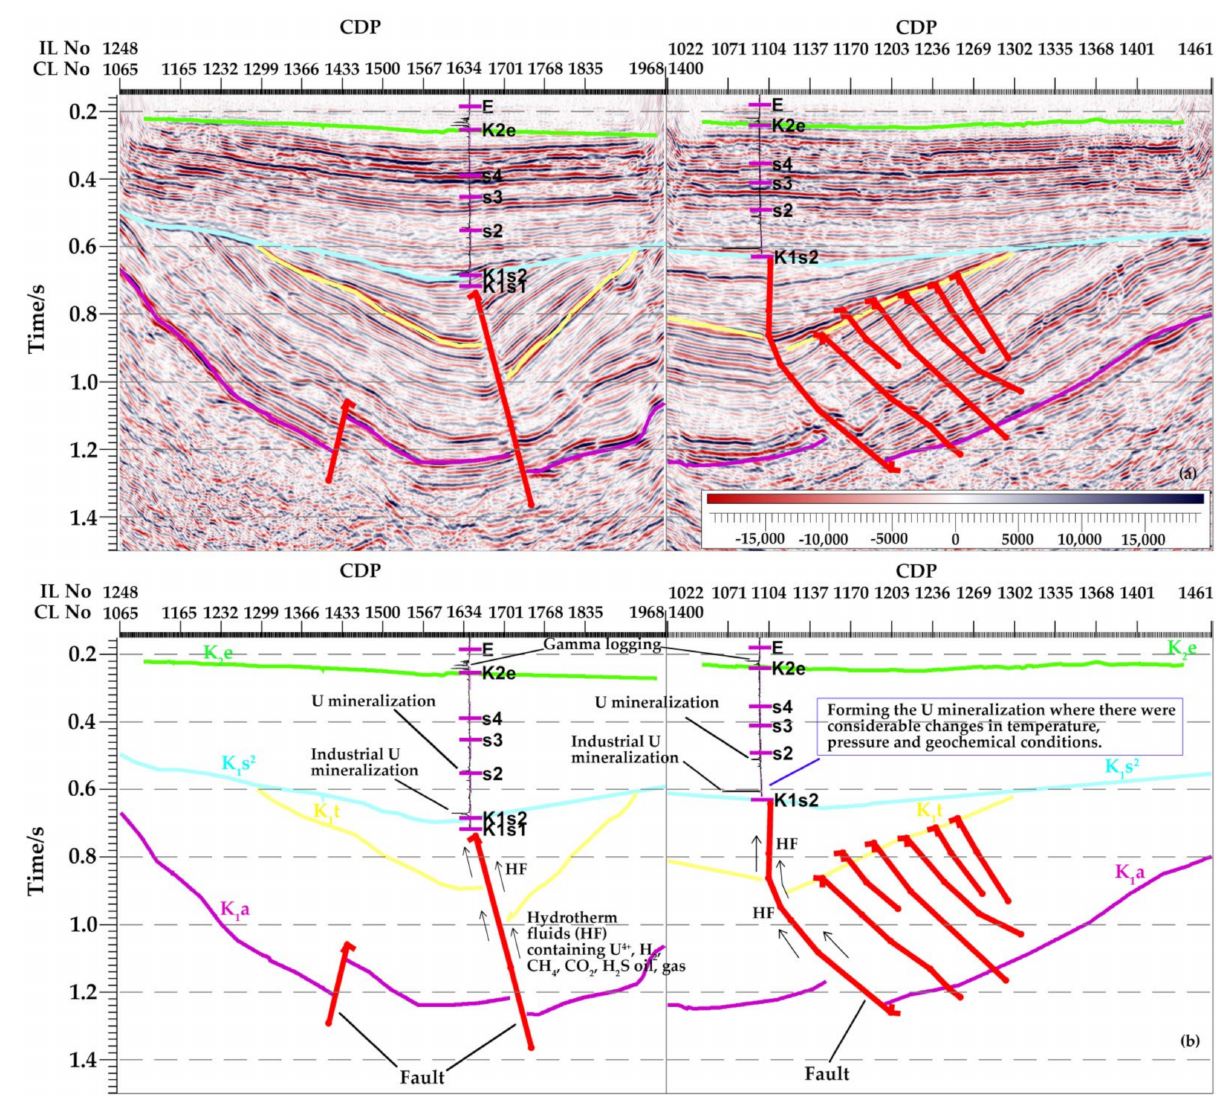
Figure 13. The interpretation of the cross-well seismic profile ( a ) and the prediction of the U-forming process ( b